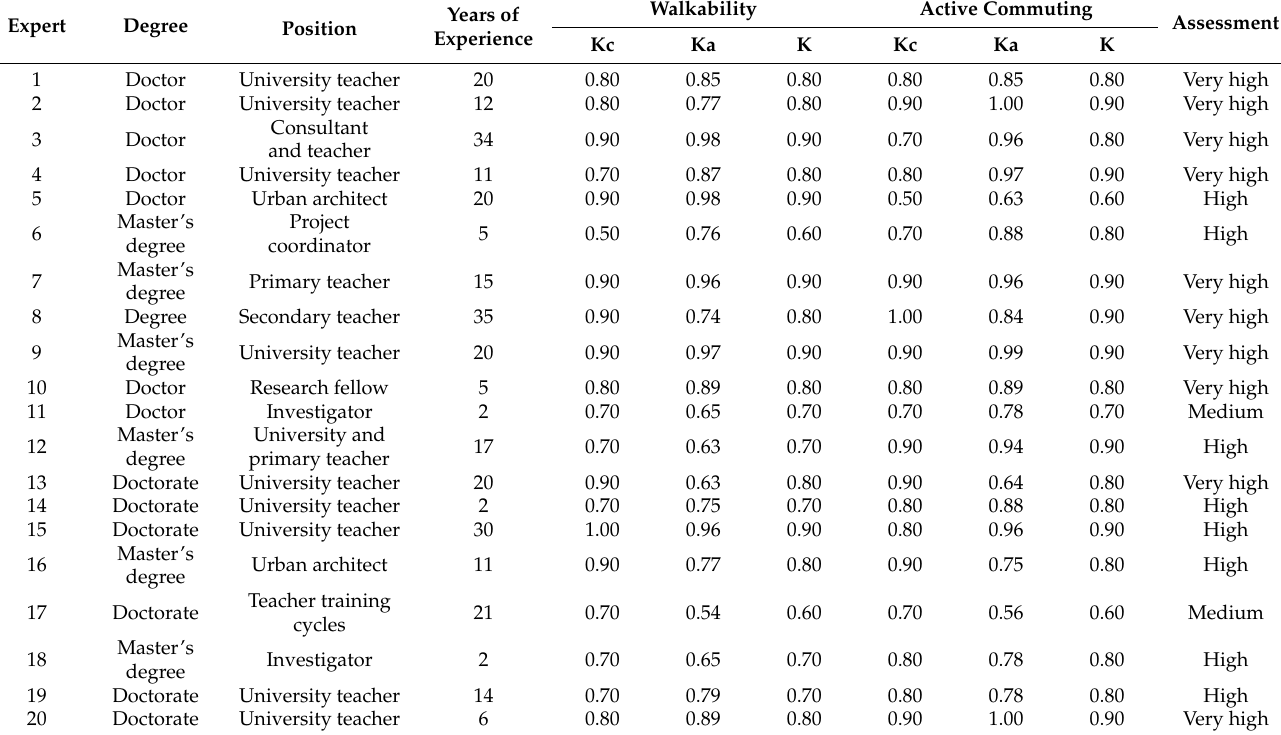
Table 2. Expert characterization and processing results for determining the expert proficiency